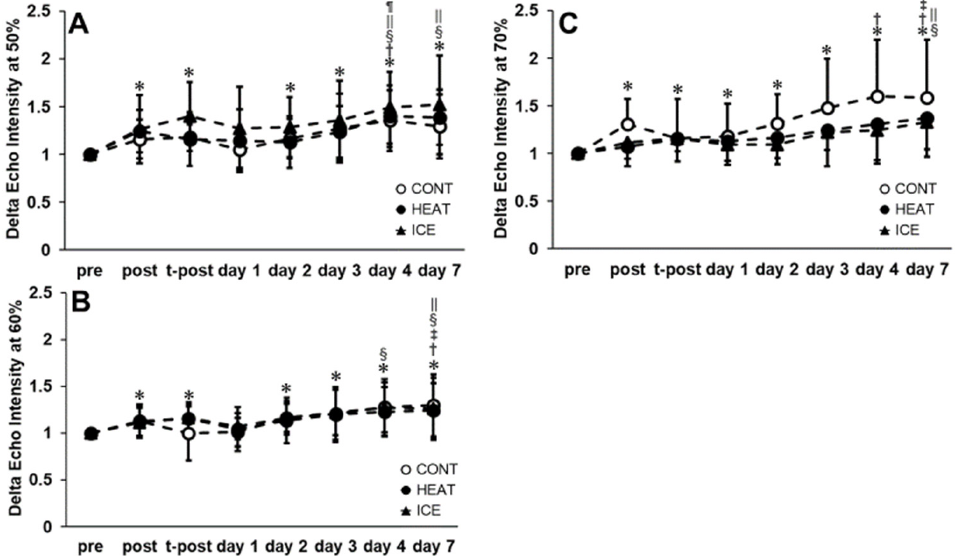
Figure 8. Changes in echo intensity at 50% ( A ), 60% ( B ), and 70% ( C ) of the upper arm. *, Significant compared with pre ( p < 0.05); †, significant compared with post; ‡, significant compared with t-post; §, significant compared with day 1; ||, significant compared with day 2; ¶, significant compared with day 3.